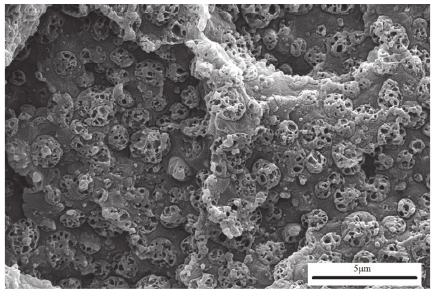
Figure 7: SEM micrographs of brittle-fractured surfaces of nanocomposite N-2 etched by